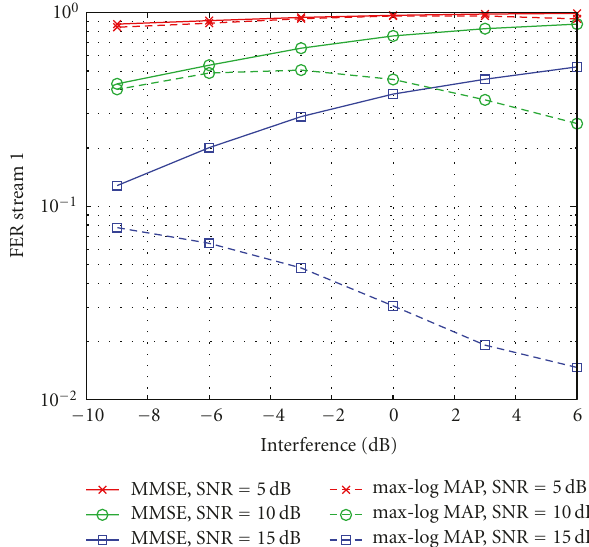
Figure 12: Frame error rate of the first stream of the of the MMSE and max-log MAP receiver for a frequency flat Rayleigh fading channel with a receive correlation of | ρ | = 0 . 75. Results are plotted for di ff erent SNR levels of the first stream. The x -axis denotes the interference of the second stream w.r.t. the first stream.